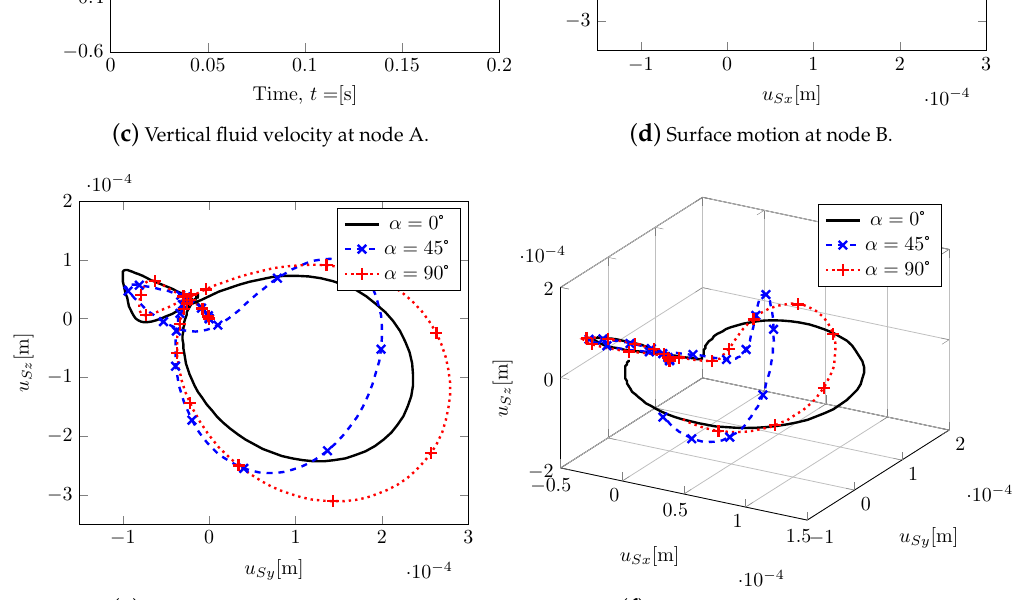
( f ) Surface motion at node C. Figure 12. Transversely isotropic soil model. Displacements and